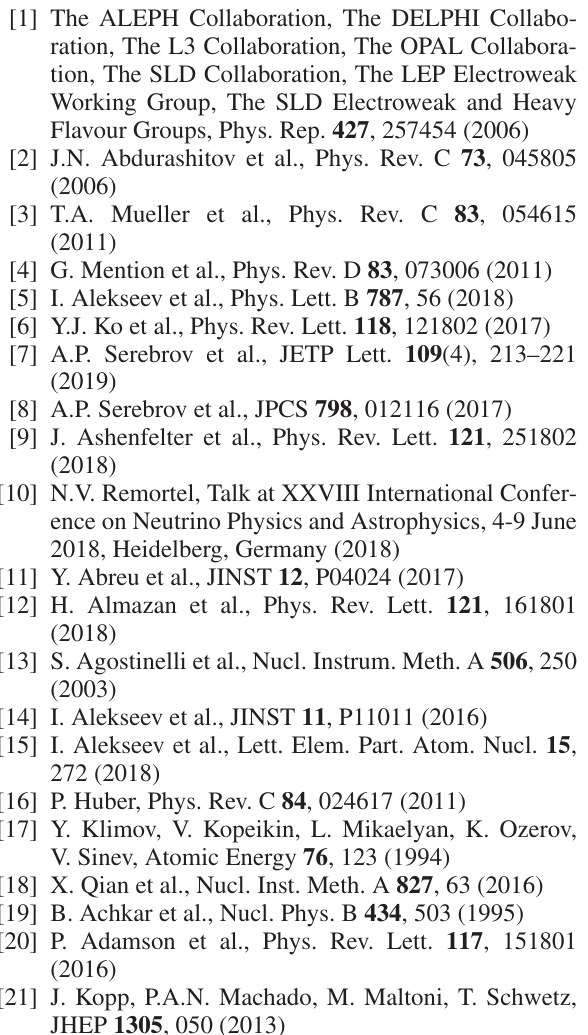
, sin 2 2 θ 14 14